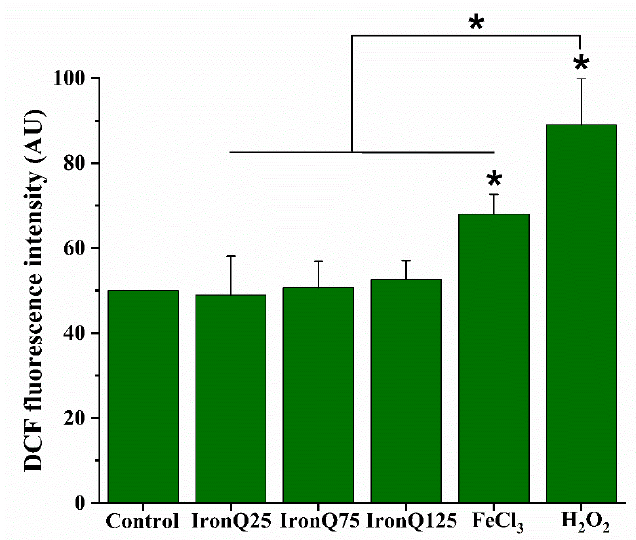
Figure 2. Oxidative stress assessment in human PBMCs upon treatment with various concentrations of IronQ by measuring the ROS level. The bar graph represents the quantitative analysis of ROS formation. PBMCs treated with 500 µ M H 2 O 2 were considered as positive controls. Data are expressed as mean ± SD of eight independent samples. * p < 0.05, significantly different versus control. ROS: reactive oxygen species; PBMCs: peripheral blood mononuclear cells.